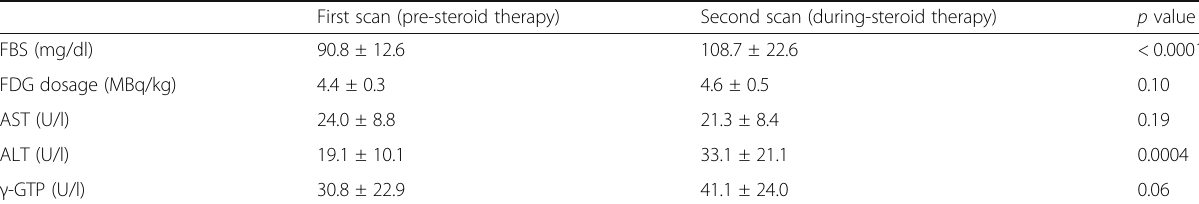
Table 7 Blood sample data First scan (pre-steroid therapy) Second scan (during-steroid therapy)